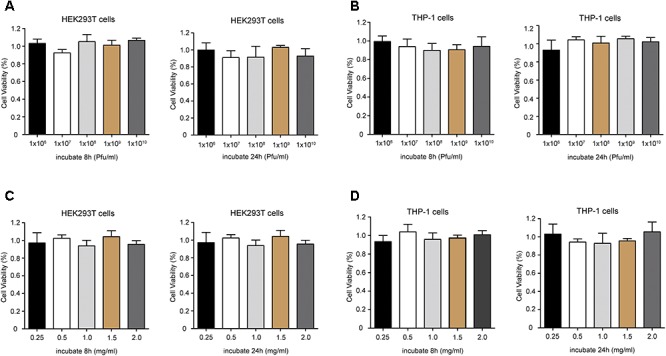
Cell viability of HEK293T and THP-1 cells after incubation with different concentrations of Phage PD6A3 (A,B) and endolysin Ply6A3 (C,D). Cells were incubated with different concentrations of phage PD-6A3 (106–1010 Pfu/mL) and endolysin Ply6A3 (0.25–2 mg/mL) for 8 h then followed by fresh complete media for 16 h. Or only incubated with different concentrations of phage PD-6A3 (106–1010 Pfu/mL) and endolysin Ply6A3 (0.25–2 mg/mL) for 24 h. Cell viability was measured using the CCK-8. Data are mean ± SD (n = 6). All the result shows that cell lines remained highly viable after incubation with endolysin Ply6A3. Ply6A3, the endolysin encoded by a novel Acinetobacter baumannii Phage PD6A3 gene. HEK293T cells, human embryonic kidney cells 293. THP-1 cells, a human monocytic cell line derived from an acute monocytic leukemia patient. CCK-8, Cell Counting Kit-8.